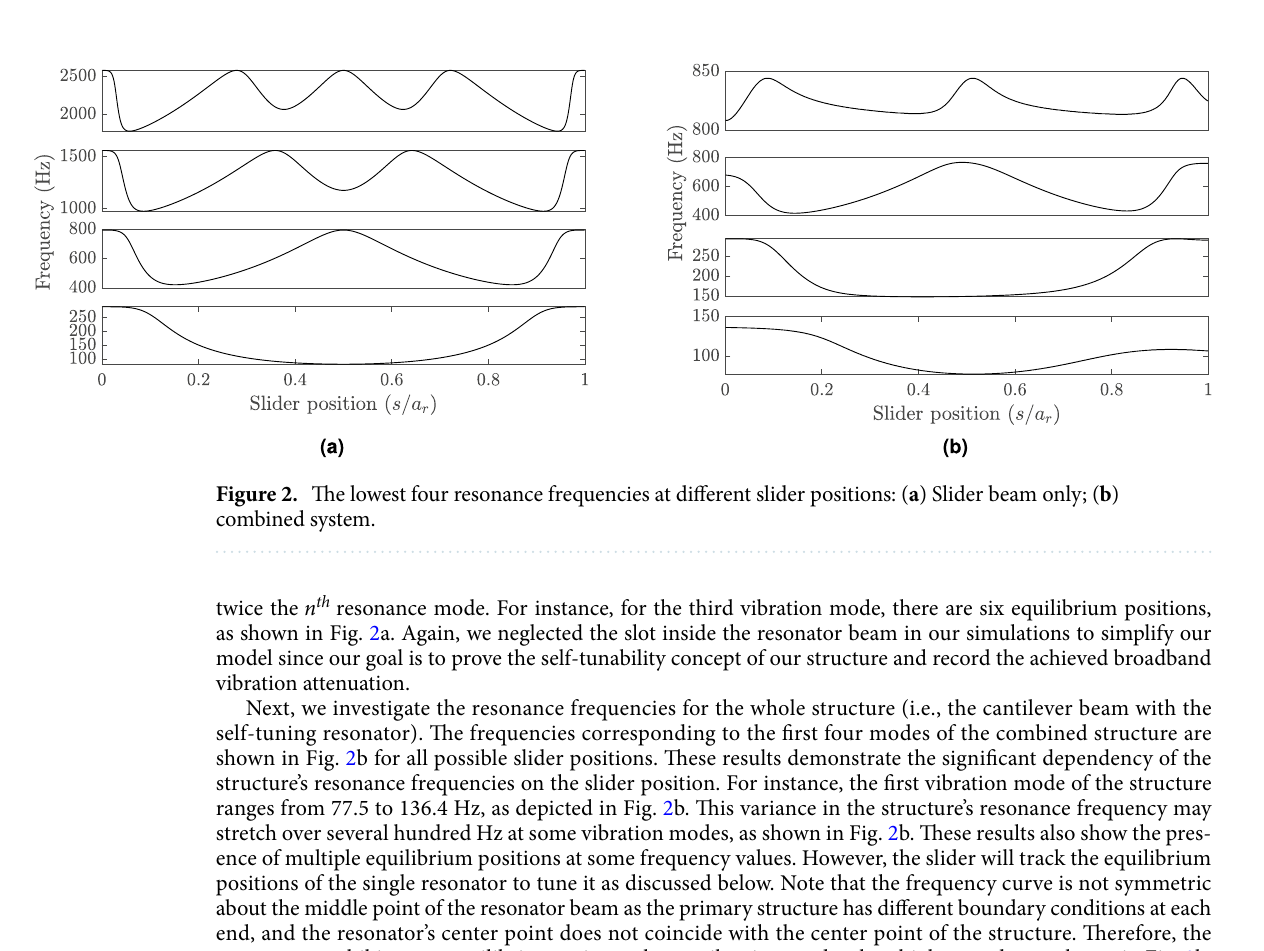
Table 1. System key parameters.